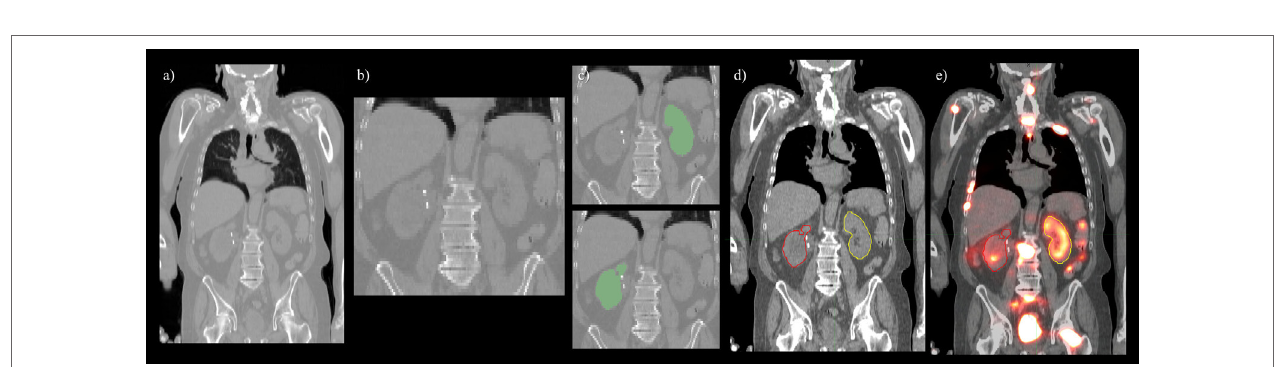
FigUre 1 | Layer structure and dimensions for the semantic convolutional neural network used in this study. Fully three­dimensional convolutional network structure is adapted from a work by Pazhitnykh et al.